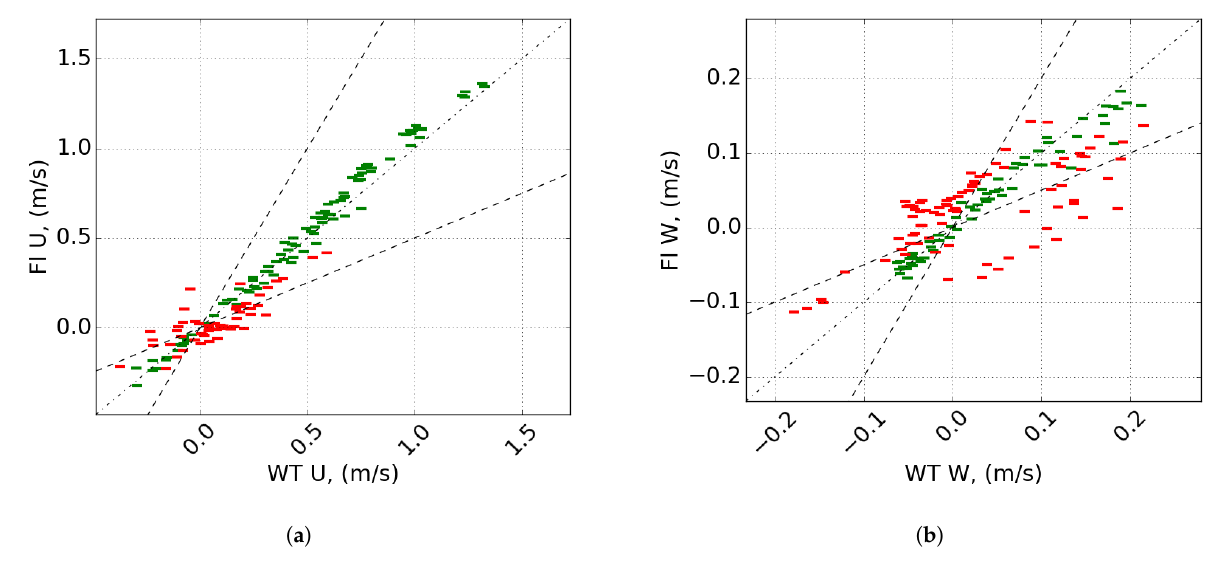
Figure 5. Scatter plots of ( a ) u and ( b ) w for the wind tunnel and LES. Green markers indicate values which meet the criteria, red markers indicate values which do not meet the criteria. Dotted line is the x = y line, dashed lines are the factor 2 lines. Table 2. Performance statistics of LES against the WT. Values which do not reach the proposed criteria are shown in bold.